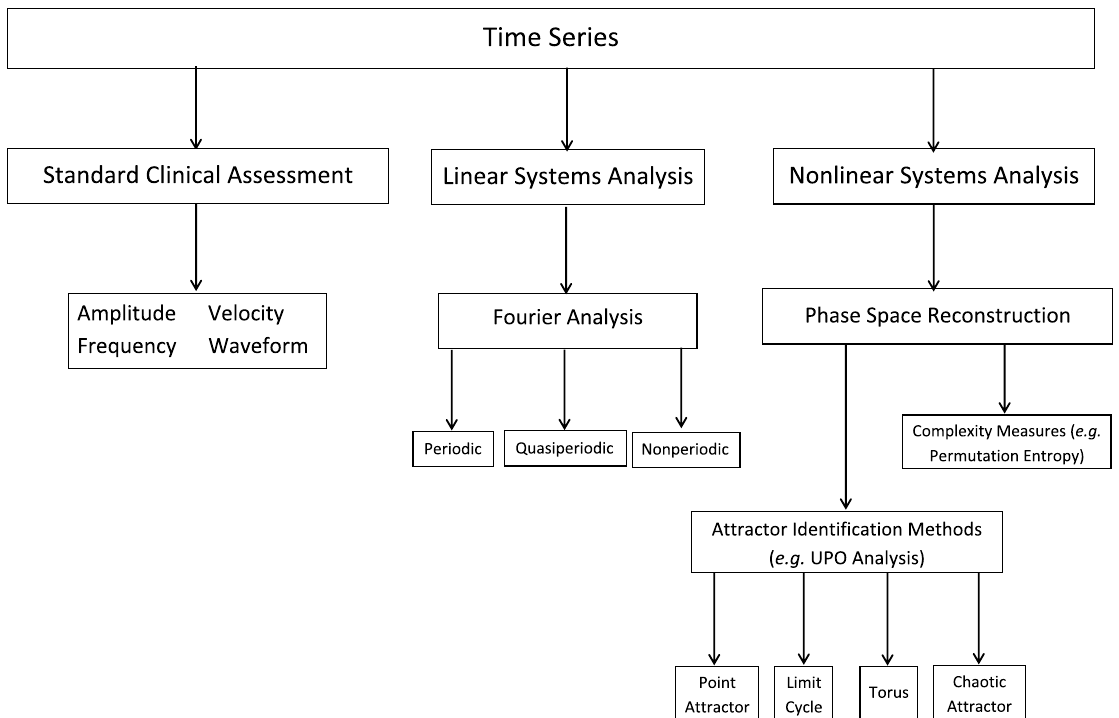
Figure 1. A computational framework for analysing a nystagmus time series that combines linear and nonlinear investigative methods to supplement the standard clinical assessment. The linear and nonlinear systems analyses are based on spectral decomposition and attractor reconstruction